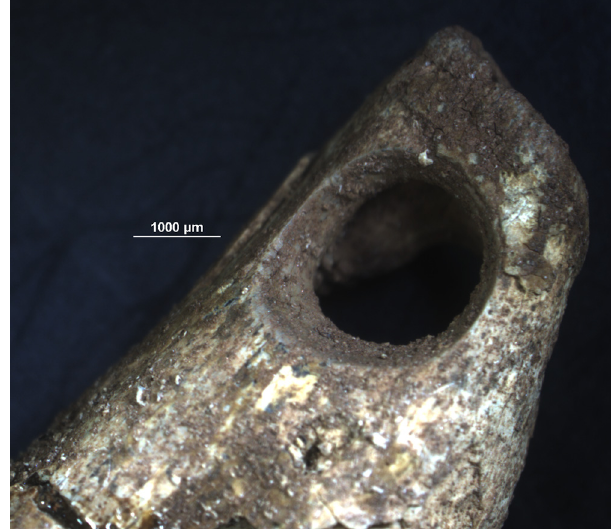
Figure 4: Perforation in elk tooth discussed in this study. Photo: Lars